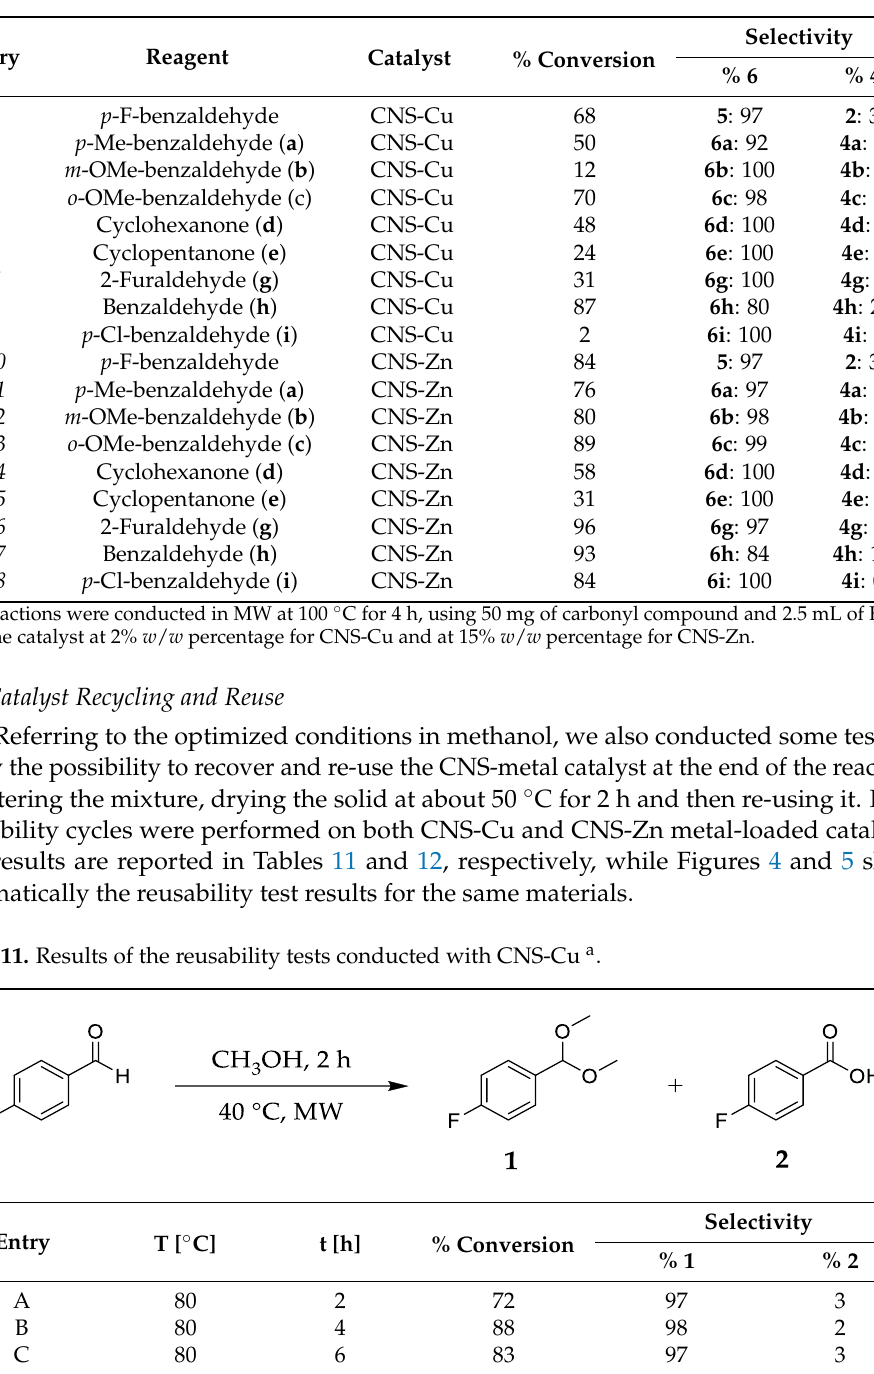
Table 10. Reactions with different carbonyl compounds using ethanol as solvent *.